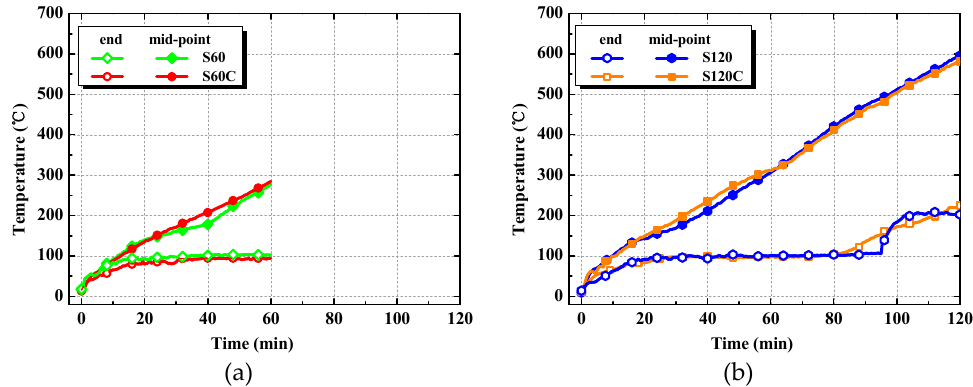
Figure 13. Measured temperature-time curves of joint bolts. ( a ) Heating duration = 60 min; ( b ) heating duration = 120 min.